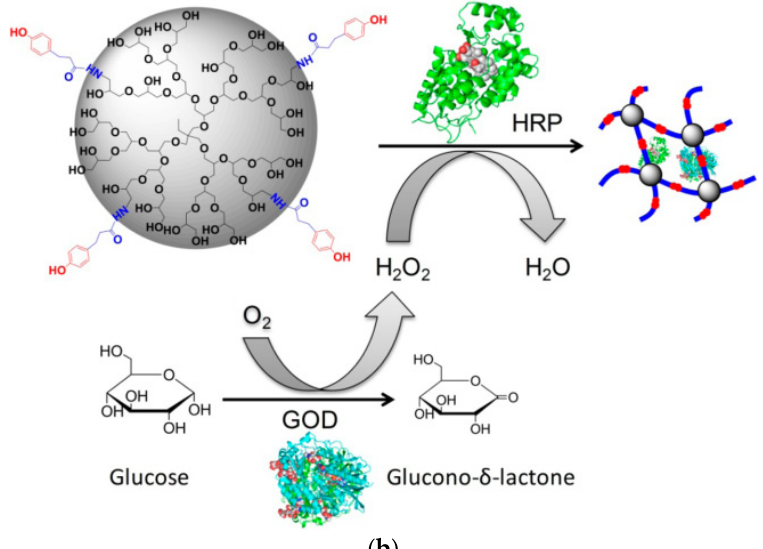
Figure 9. ( a ) Formation of PG Hydrogels by HRP Cross-Linking; ( b ) PG gel formation via gluco- δ - lactone triggered by glucose. Both were reproduced with permission from [142].